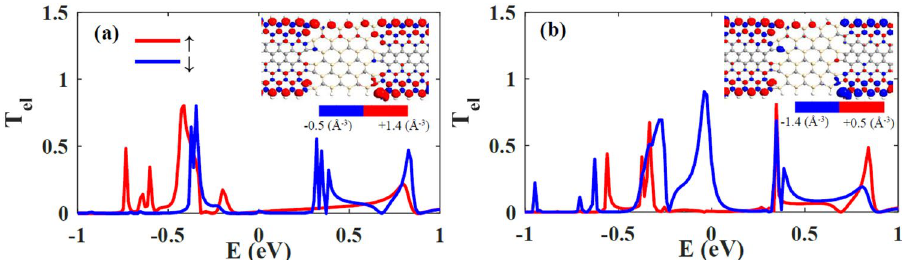
Figure 2. The spin-up (red lines) and spin-down (blue lines) electron transmission coefficients of SiCNR in ( a ) P and ( b ) AP configurations. The insets show the spin density diagram of the junction. Red (blue) color represents the spin-up (-down) density and the mean values of spin densities are given in the scroll bar at the bottom of the diagrams .